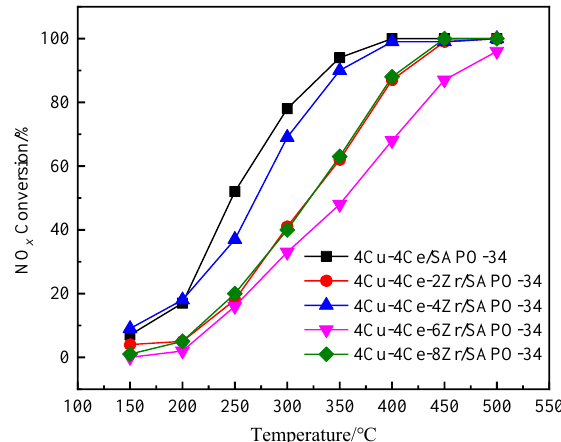
Figure 1. NO x conversion of catalysts with different Zr